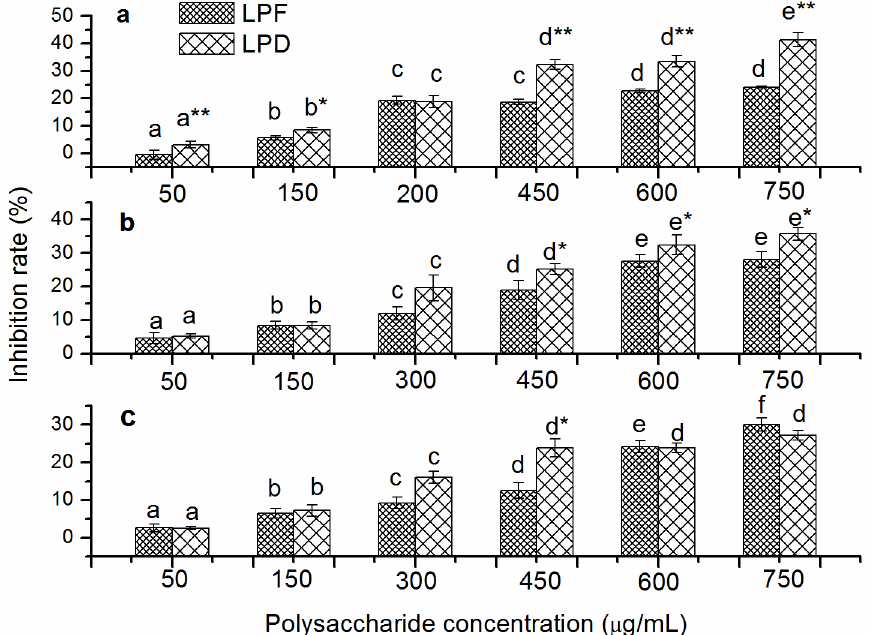
Figure 2. The inhibition of proliferation of cancerous cells by the litchi polysaccharides LPF and LPD. HepG2 ( a ), Hela ( b ), and A549 ( c ) cells were incubated at different concentrations (50, 150, 300, 450, 600 and 750 μ g/mL). The percent inhibition were assessed by the methylene blue method and expressed as the mean ± standard deviation ( n = 6). Bars labeled with different letters represent a statistical difference at p < 0.05 among different concentrations of the same sample. ( * ) 0.01 < p < 0.05 and ( ** ) p < 0.01 compared with